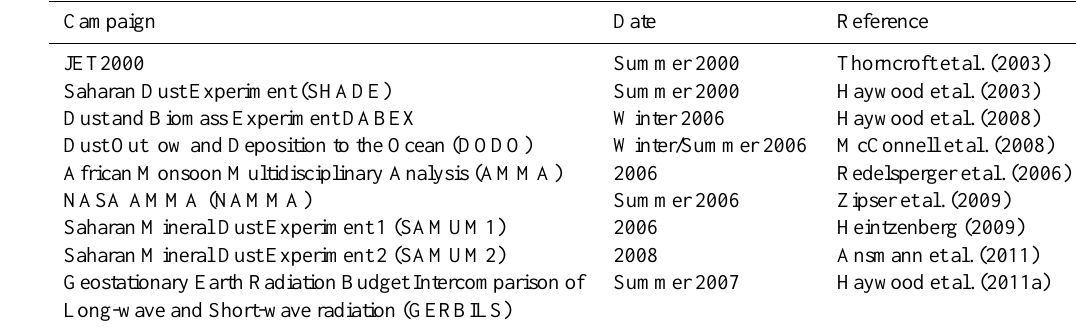
Table 1. Previous aircraft programmes in the region.